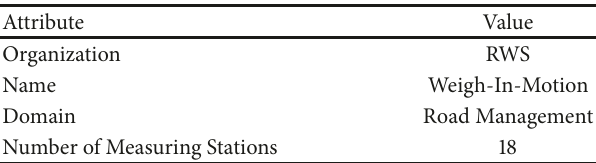
Table 1: Case study